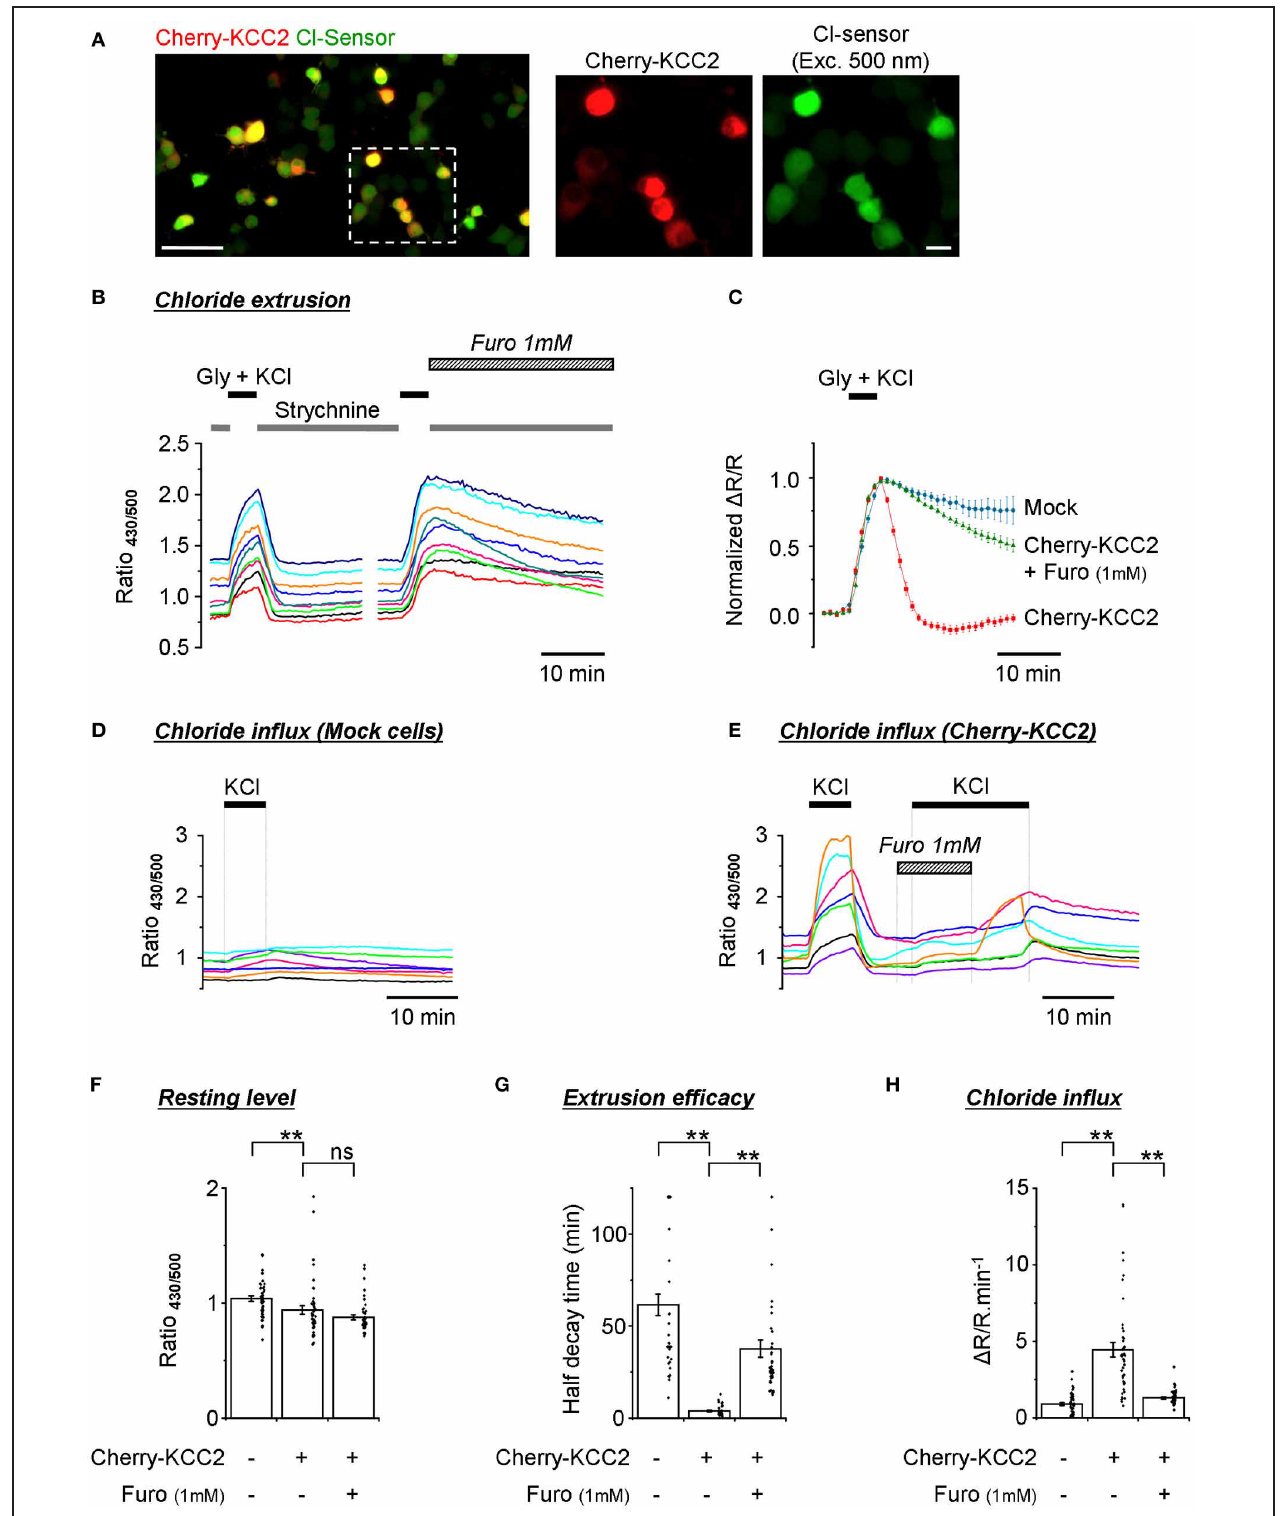
FIGURE 7 | Monitoring of the activity of exogenously expressed KCC2 using the improved Cl-Sensor method. (A) The left image illustrates a typical merge image of N2a cells cotransfected with Cl-Sensor (green) and cherry-KCC2 (red). The middle and right images show expression of